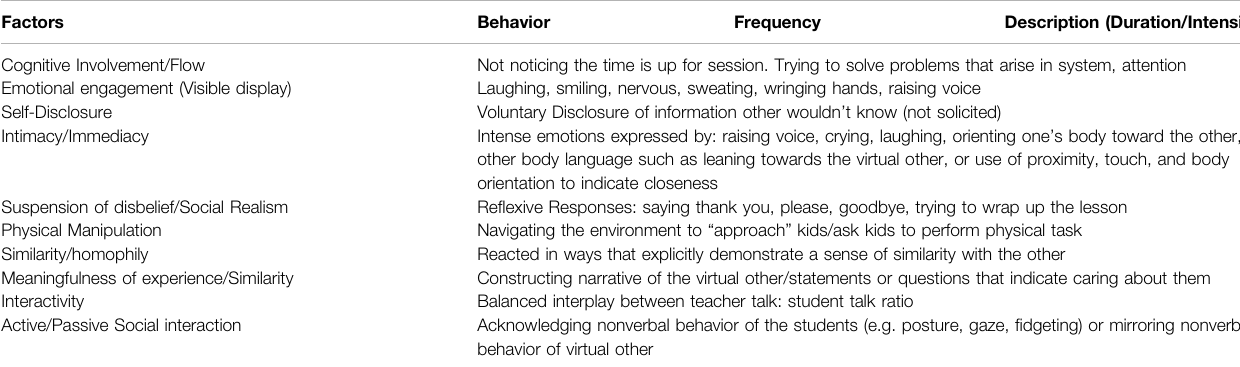
TABLE 4 | Revised social presence behavioral coding system